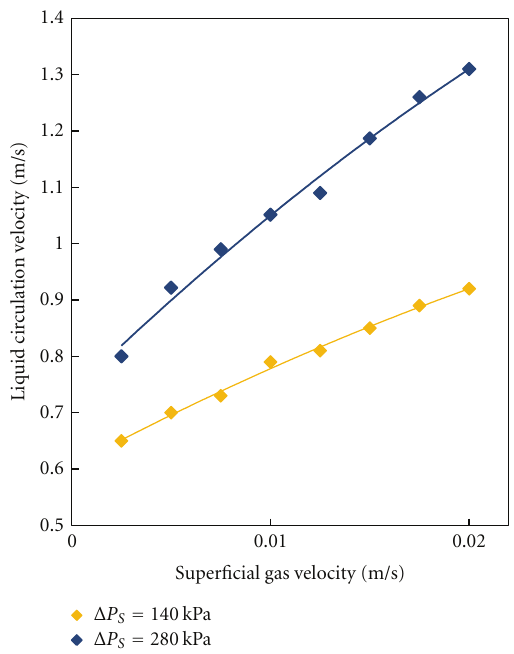
Figure 13: E ff ect of surfactant concentration on liquid circulation velocity ( U G = 0 . 008 ms − 1 , W L /W G =